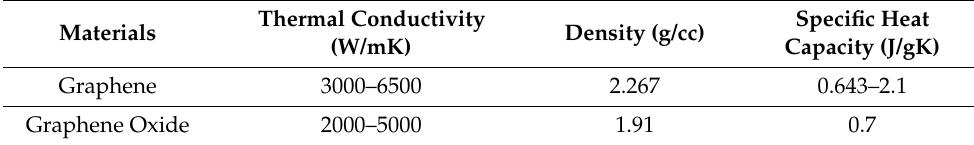
Figure 2. Number of published articles ( a ) heat transfer with nanofluids, ( b ) heat transfer with graphene-based nanofluids. Source: Web of Science. Table 1. Thermal properties of graphene materials.